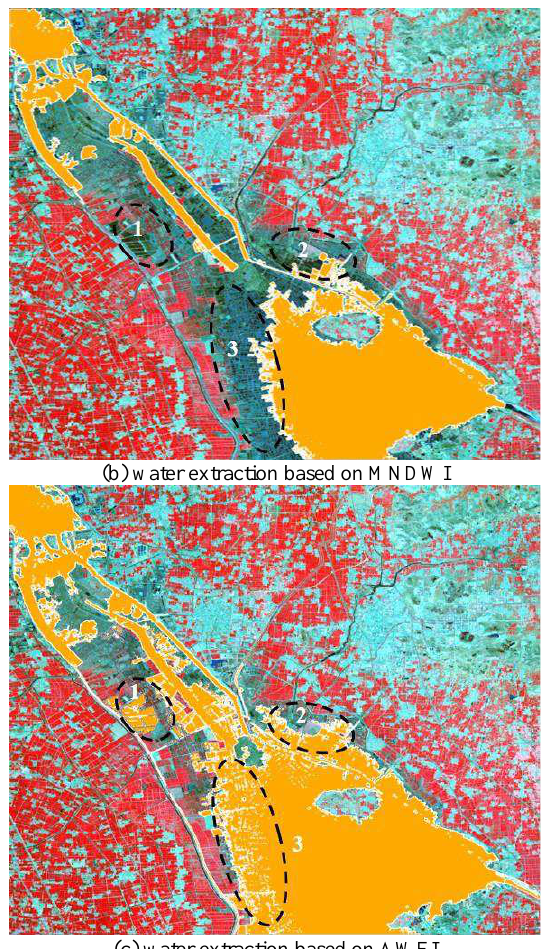
Figure 9. Water Extraction Results for the AHSI image of Nansi Lake